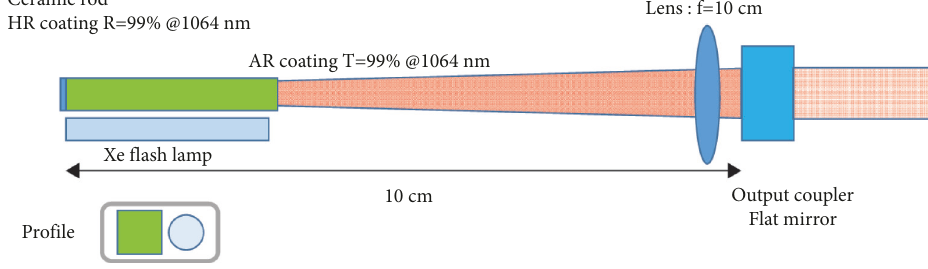
Figure 5: Experimental setup for laser oscillation.